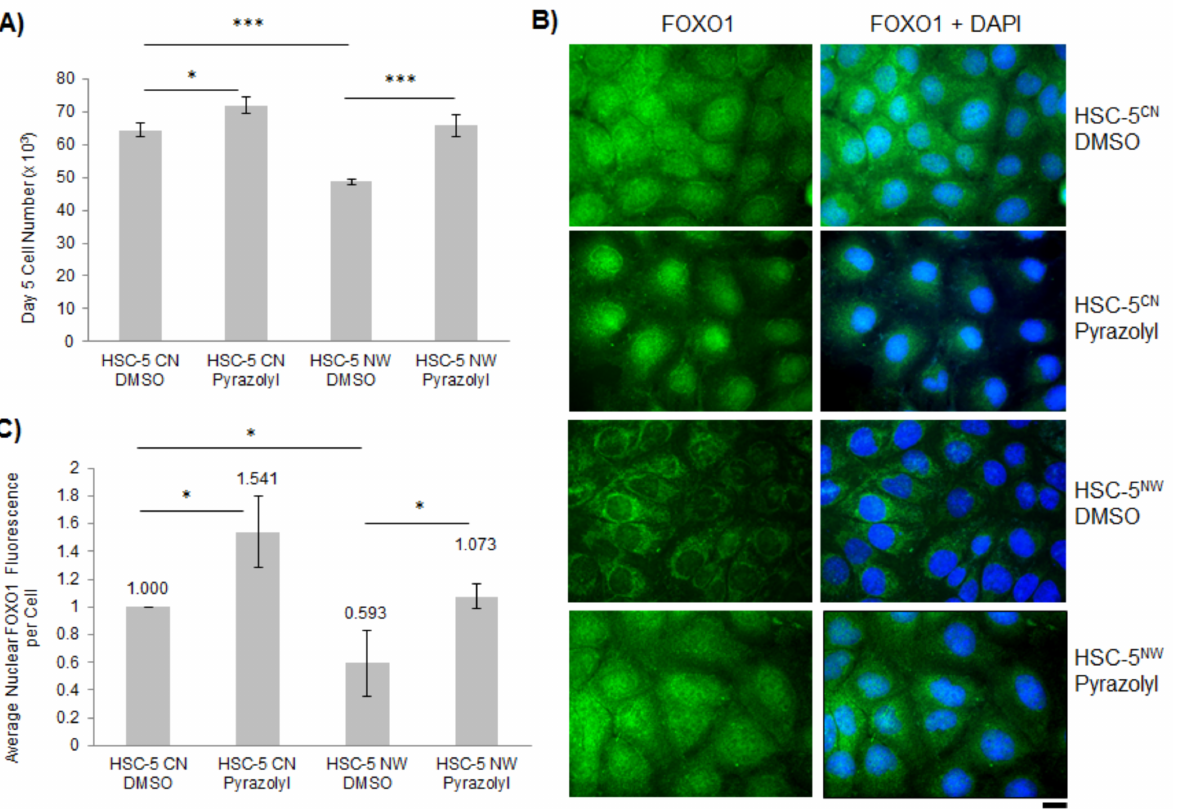
Figure 5. Inhibition of ERK2 in HSC-5 NW cells restored cell proliferation and stabilized nuclear FOXO1. ( A ) The graph shows the total cell number after 5 days of incubation of HSC-5 CN and HSC-5 NW cells treated with 2 nM Pyrazolyl or DMSO. ( B ) Representative immunofluorescence images of HSC-5 CN and HSC-5 NW cells treated as in ( A ) stained for FOXO1 (green). Nuclei were counterstained with DAPI (blue). Scale bar represents 20 µ m, n = 3. ( C ) Quantification of nuclear FOXO1 fluorescence from 20 randomly chosen cells per experiment and normalized to DMSO-treated HSC-5 CN cells. All values are the mean ± SD, n = 3, * p < 0.05, *** p <